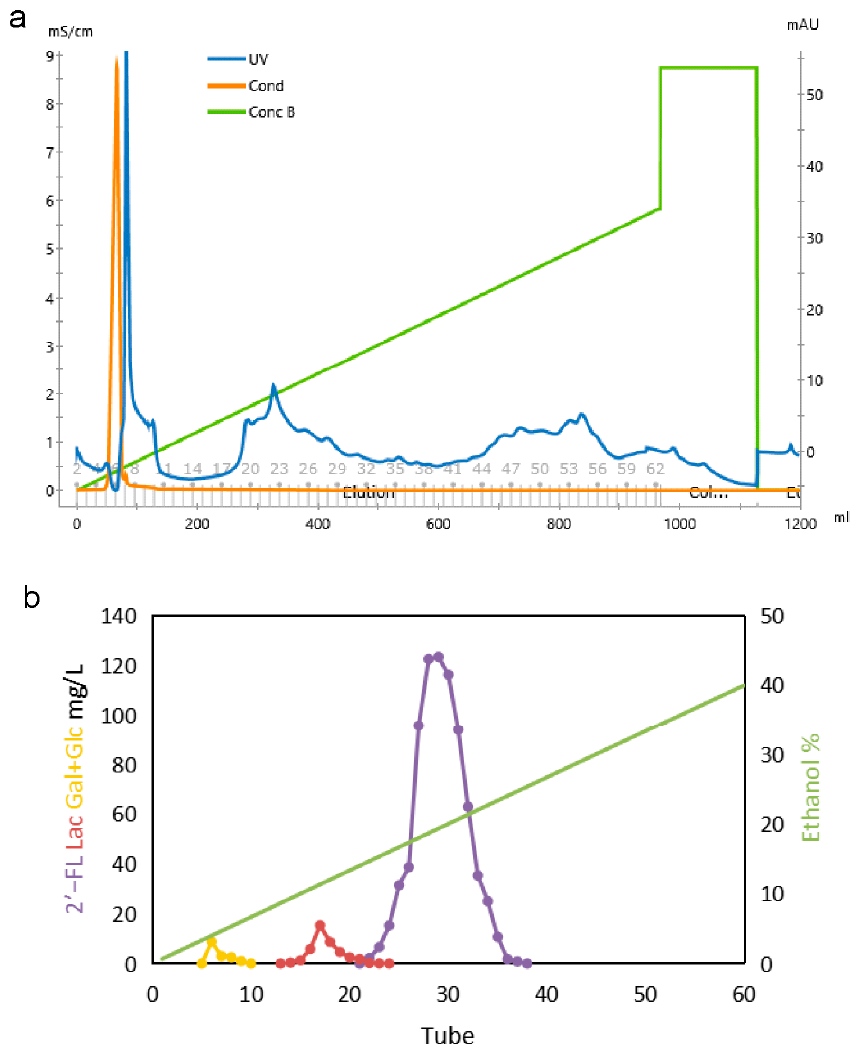
Figure 3. Results of linear elution of activated carbon by ethanol (by green line, concentration). ( a ) Conductivity (orange line, values on left axes in mS/cm) and UV280 absorbancy (blue line, right axes in mAU) vs. eluate volume (mL or number of sample tubes on horizontal axes); ( b ) Concentration of various sugars and ethanol concentration (green line) vs. eluate volume (number of sample tubes).